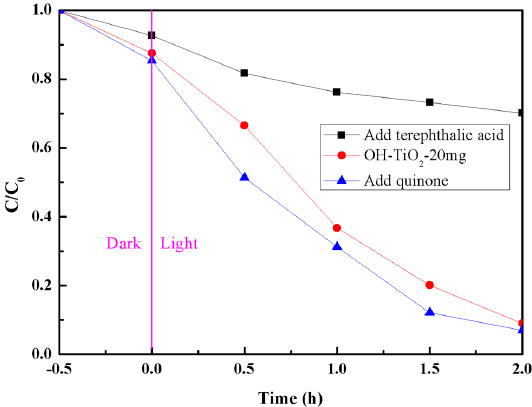
Figure 7. Radical ‐ scavenging experiments of OH ‐ TiO 2 and F ‐ TiO 2 toward MB.